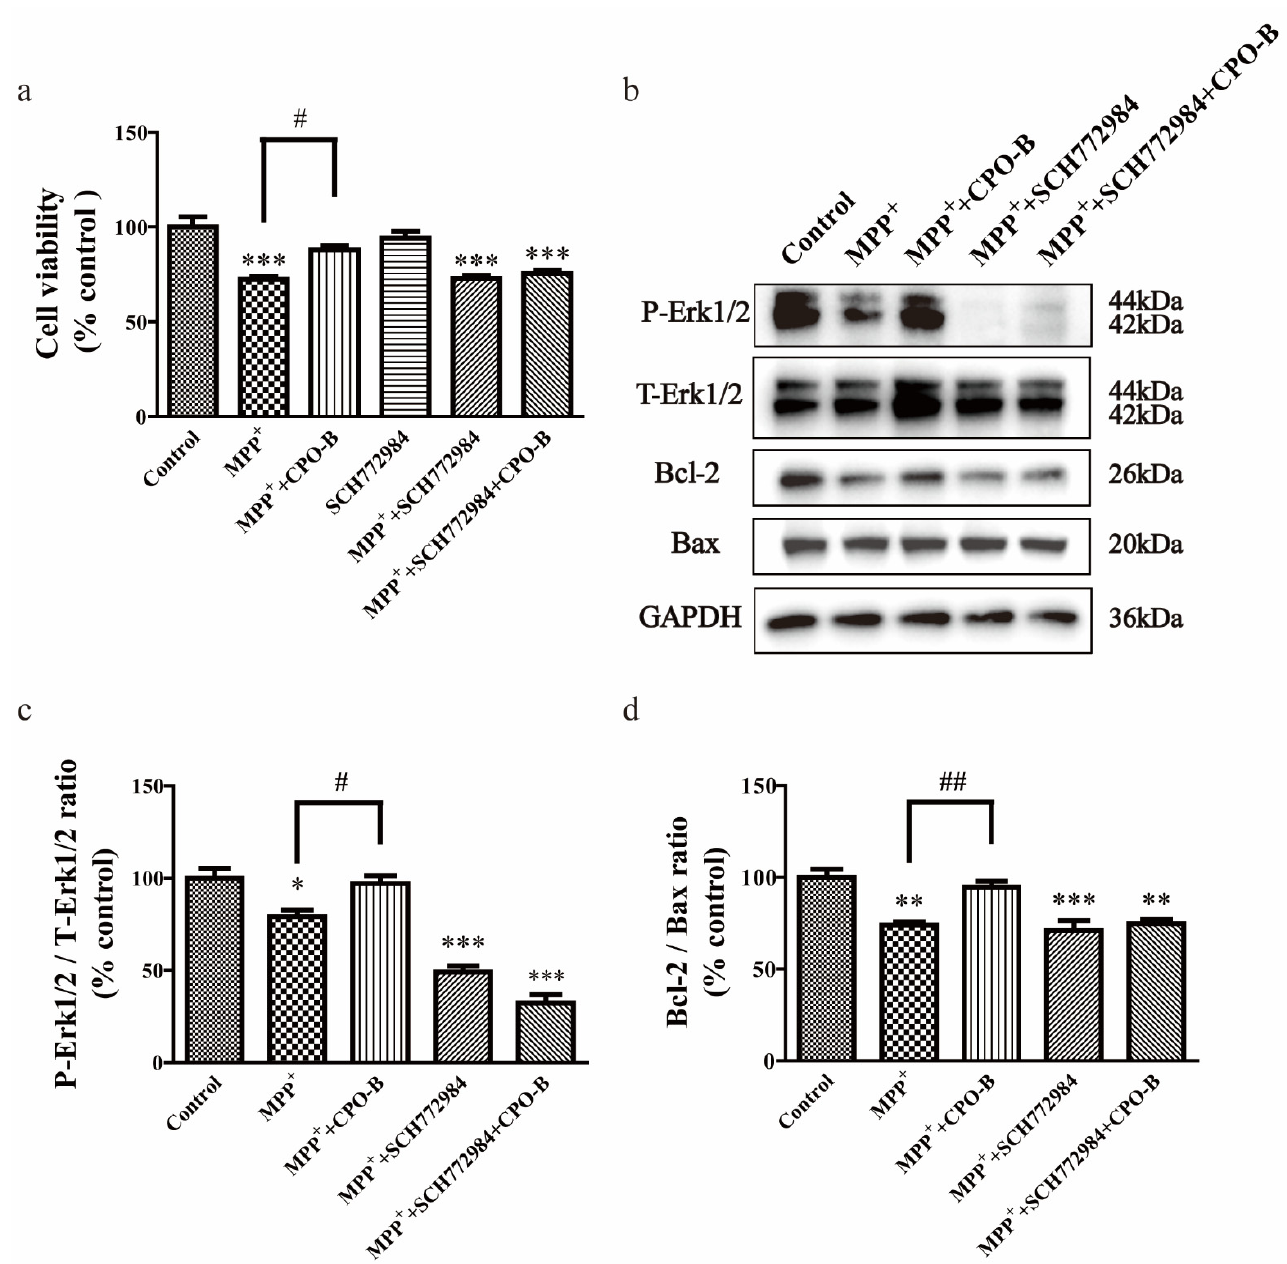
Figure 4. The effect of Erk1/2 inhibition on CPO-B-mediated neuroprotection measured by cell viability ( a , n = 3), Erk1/2 phosphorylation ( c , n = 3) and Bcl-2/Bax expression ratio ( d , n = 3). The top panel in the figure shows representative Western blots ( b ). The values (mean ± SEM) were normalized to control; symbol * indicates the difference between control and other treatments; symbol # indicates the difference between MPP + and MPP + +CPO-B; * p < 0.05, ** p < 0.01, *** p < 0.001, # p < 0.05, ## p < 0.01. CPO-B, B-type cinnamon procyanidin oligomer; MPP + , 1-methyl-4-phenylpyridinium; Bcl-2, B-cell lymphoma 2; Bax, Bcl-2-associated X protein; Erk1/2, extracellular signal-regulated kinase 1 and 2; P-Erk1/2, phosphorylated Erk1/2; T-Erk1/2, total Erk1/2; GAPDH, glyceraldehyde 3-phosphate dehydrogenase.